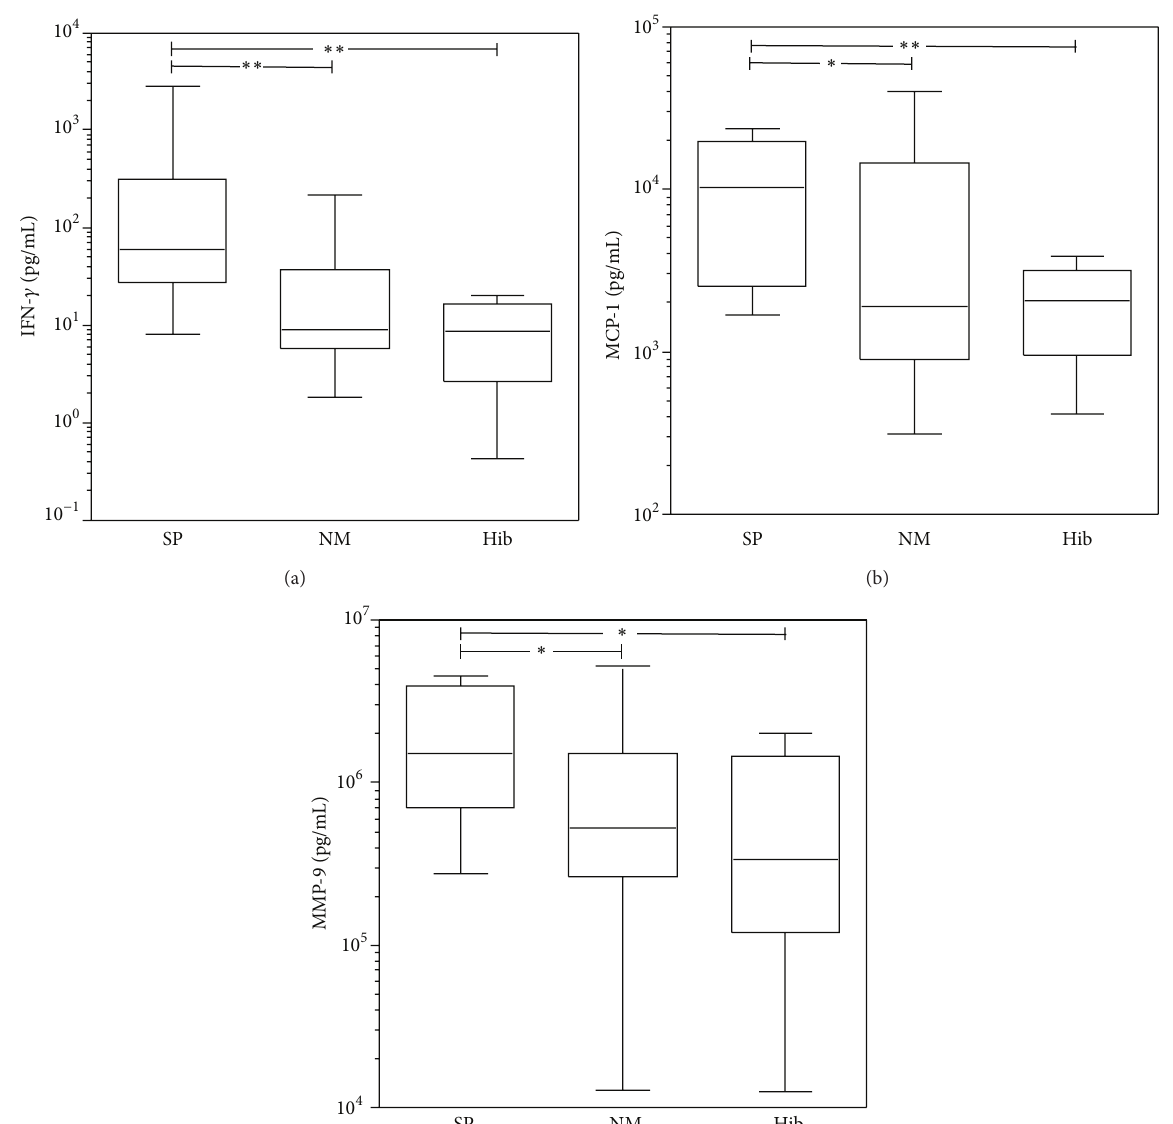
Figure 1: Inflammatory CSF parameters in BM patients. Statistically significant differences ( ∗ 𝑃 < 0.05 ; ∗∗ 𝑃 < 0.01 ) in CSF concentrations of MCP-1, IFN- 𝛾 , and MMP-9 were observed in patients with BM grouped for the causative pathogens.